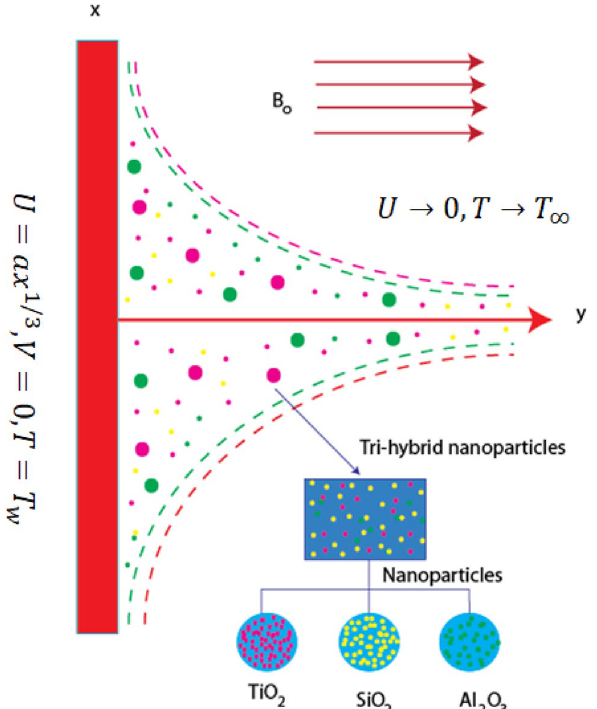
Figure 3. Physical model of developed